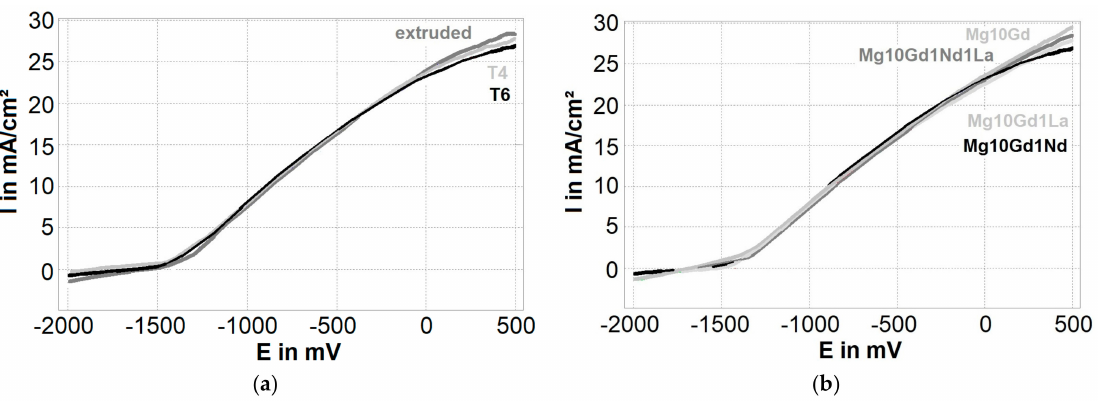
Figure 12. Current density-potential curves from polarization tests of Mg10Gd1Nd in different heat treatment condition ( a ) and in the T6 condition of all alloys ( b